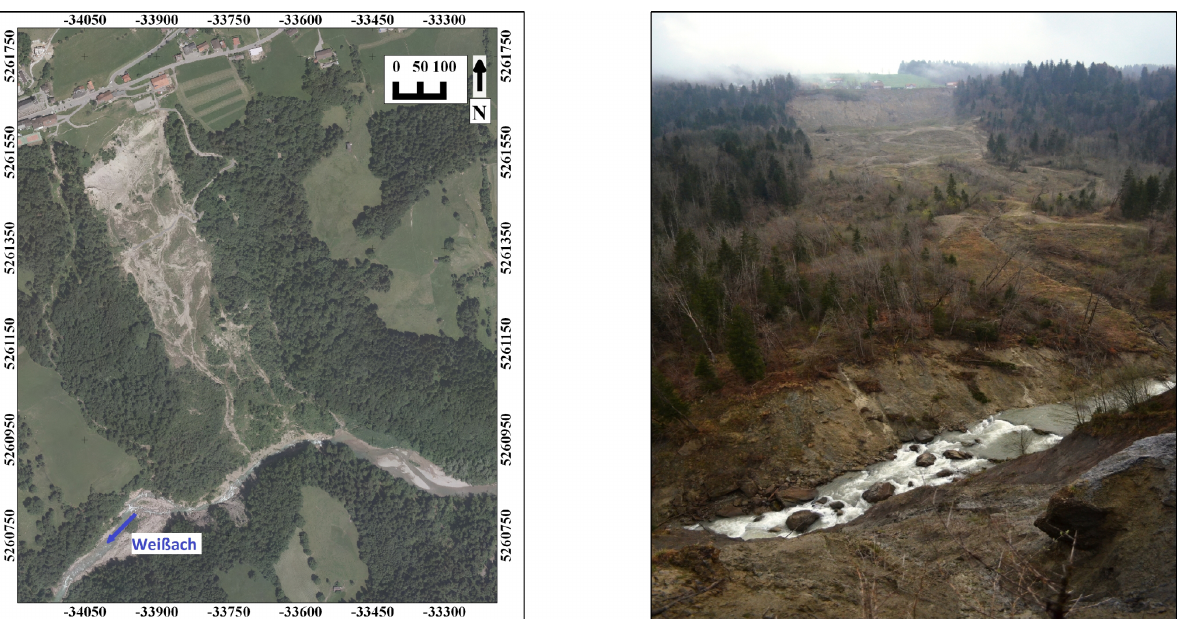
Figure 1. ( Left ) Orthophoto of the landslide from 2012; ( Right ) Photograph of the landslide area (view is towards